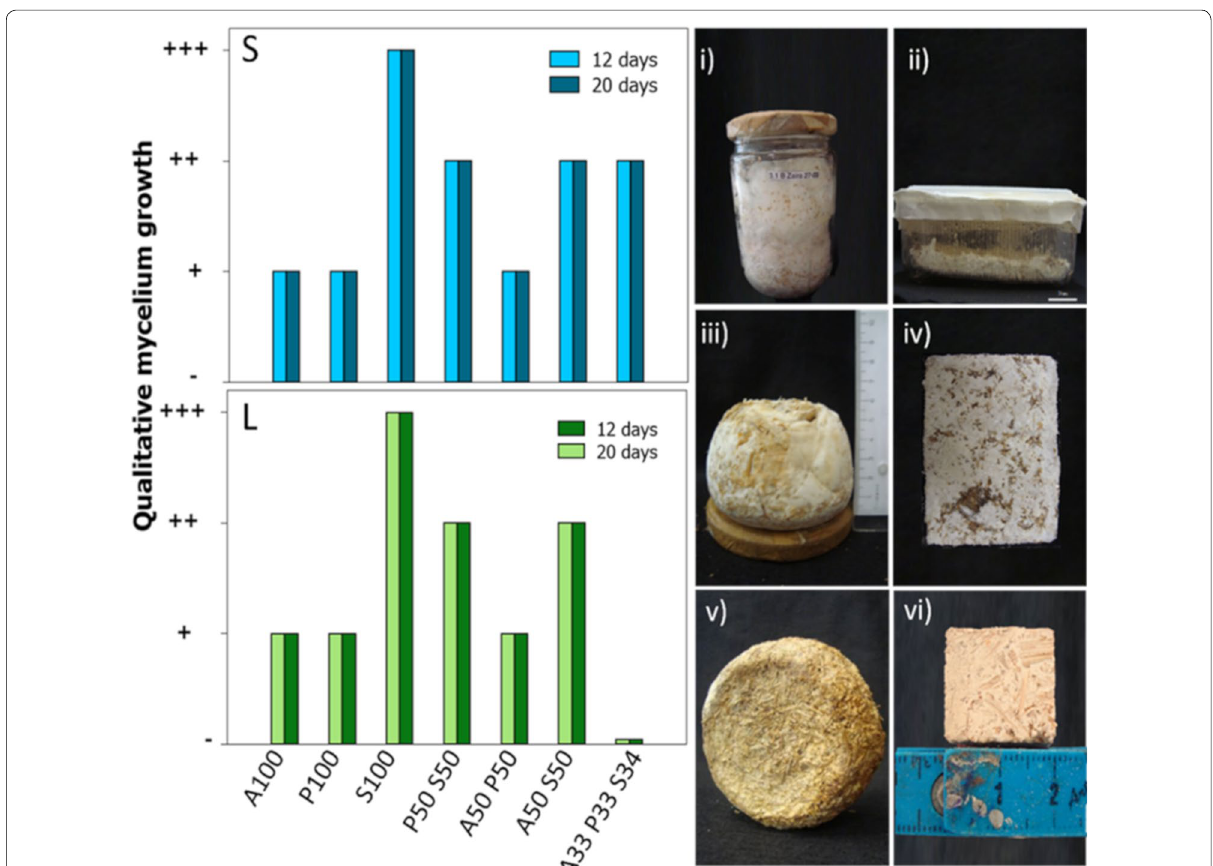
Fig. 4 Qualitative mycelium growth from the studied feed ––source treatments, varying from lack to optimum at time points of 12 and 20 days using a solid (S) or liquid (L) inoculum. Also, macroscopic images of the S100 treatment (i–ii) before and (iii–iv) after mycelium-composite removal from the flask, (v) is after compression and drying (cold-pressed); (vi) oven-dried, grounded, and final piece